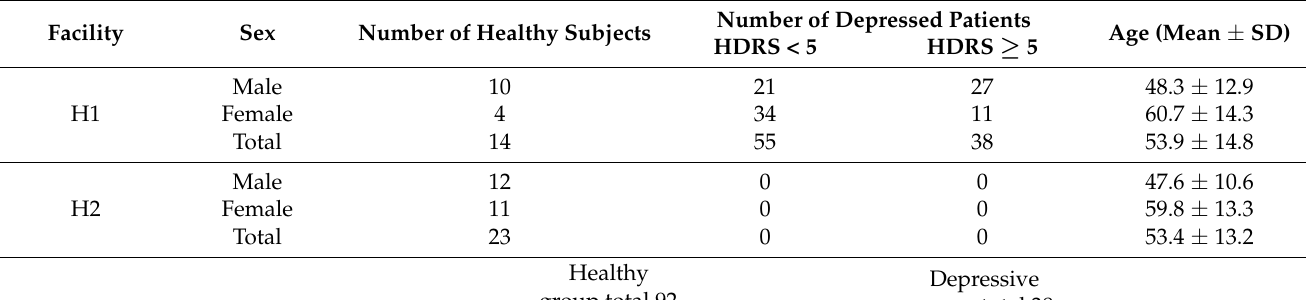
Table 1. Detailed information of